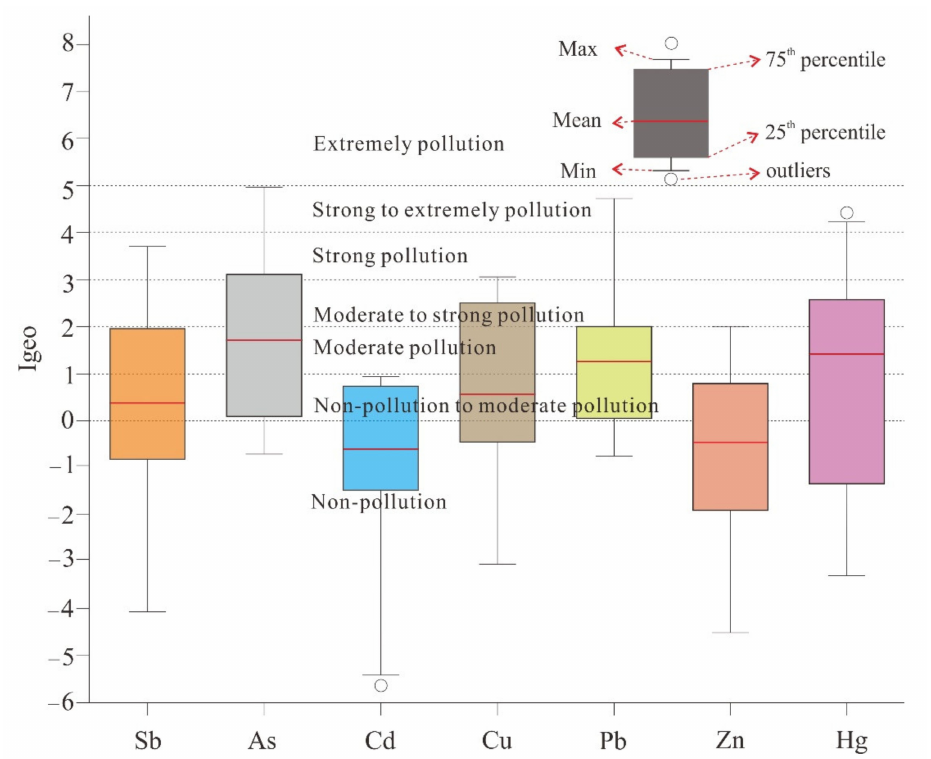
Figure 3. Whisker-box plots for geoaccumulation index of PTEs in soils.